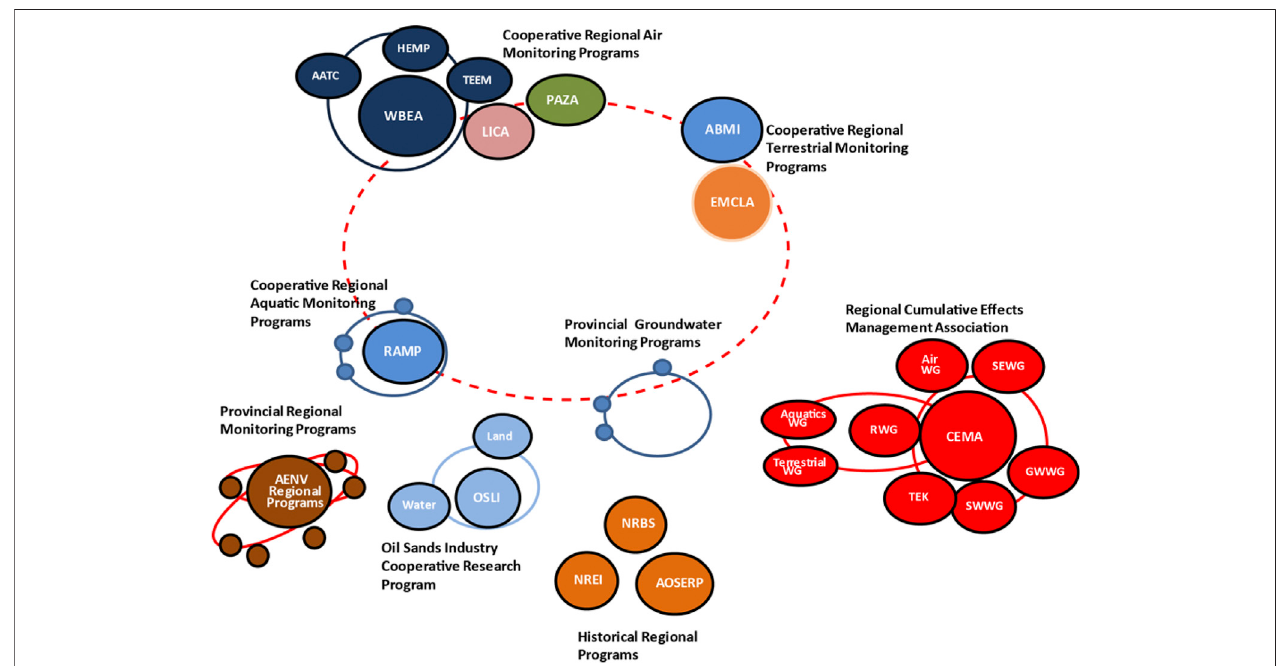
FIGURE 2 | Status of historical and current monitoring or data collection entities operating in the Oil Sands region; AOSERP (cid:1) Alberta Oil Sands Environmental ResearchProgram;NRBS (cid:1) NorthernRiverBasinsStudy;NREI (cid:1) NorthernRiversEcosystemInitiative;RAMP (cid:1) RegionalAquaticsMonitoringProgram;WBEA (cid:1) Wood Buffalo Environmental Association; TEEM (cid:1) Terrestrial Environmental Effects Monitoring; ABMI (cid:1) Alberta Biodiversity Monitoring Institute; CEMA (cid:1) Cumulative Effects Management Association; AENV (cid:1) Alberta Environment; OSLI (cid:1) Oil Sands Leadership Initiative; EMCLA (cid:1) Ecological Monitoring Committee for the Lower Athabasca; PAZA (cid:1) Peace Airshed Zone Association; LICA (cid:1) Lakeland Industry and Community Association; SEWG (cid:1) Sustainable Ecosystems Working Group; TEK (cid:1) Traditional Ecological Knowledge; GWWG (cid:1) Groundwater working group; SWWG (cid:1) Surfacewater working group; RWG (cid:1) Regional Working Group.